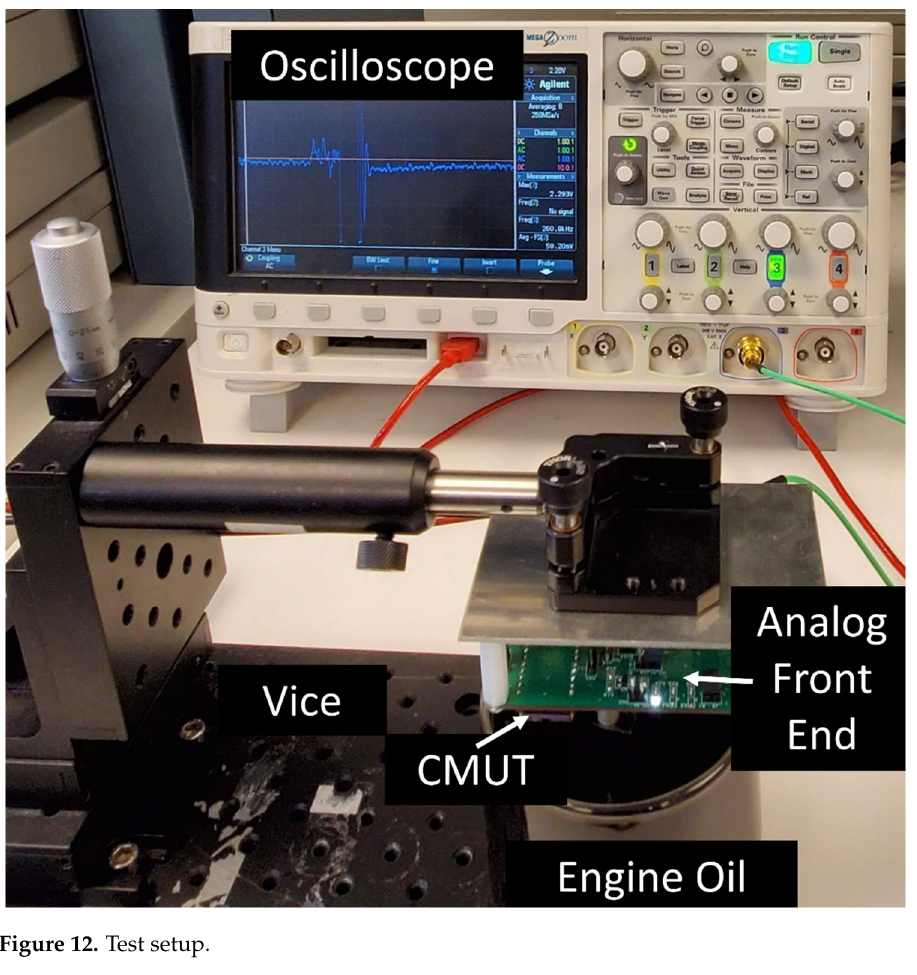
Figure 12. Test setup.